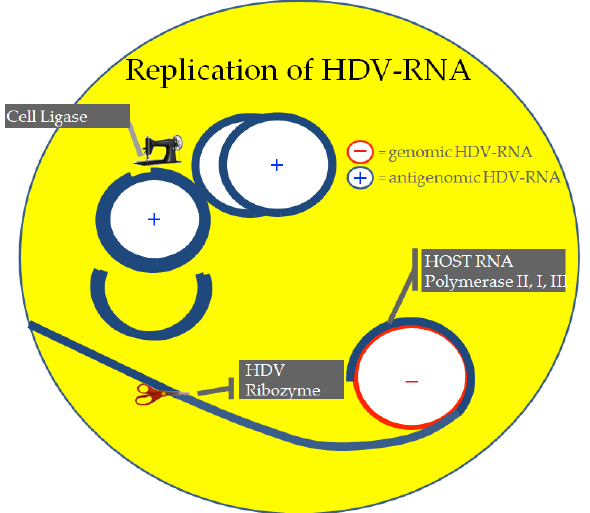
Figure 2. Replication of HDV-RNA. The HDV is replicated by DNA-dependent RNA polymerases of the hepatocytes, redirected to copy the viral RNA. The host RNA polymerases elongate a multimeric linear RNA transcript over the circular genome, which is then cut to monomeric linear HDV-RNA by the ribozyme and ultimately ligated into the circular infectious form by cell ligases.